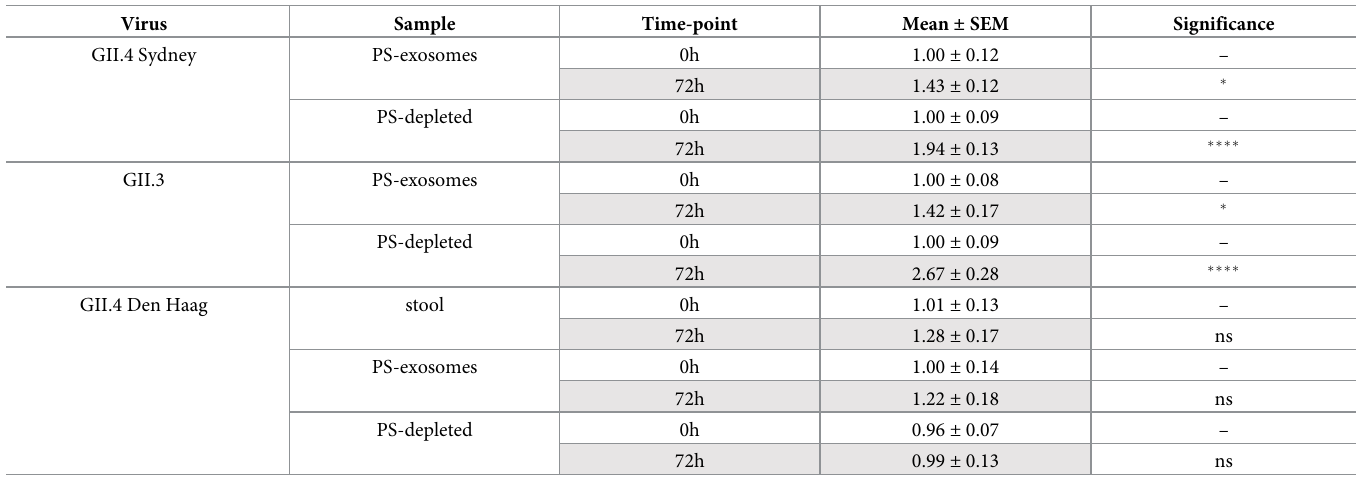
Table 2. Vero cells infected with PS-exosomes or PS-exosome depleted stool. Virus Sample Time-point Mean ± SEM Significance GII.4 Sydney